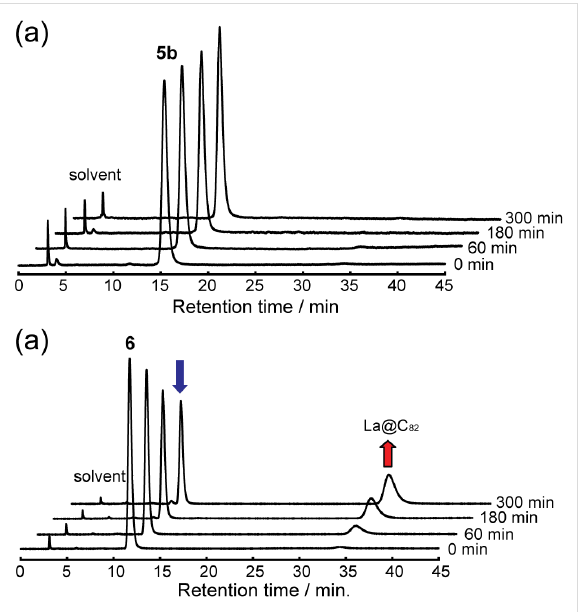
Figure 15: HPLC profiles for comparison of the thermal stabilities of (a) 5b and (b) 6 at 30 °C. Conditions: column, Buckyprep (Ø 4.6 mm × 250 mm); temperature, 40